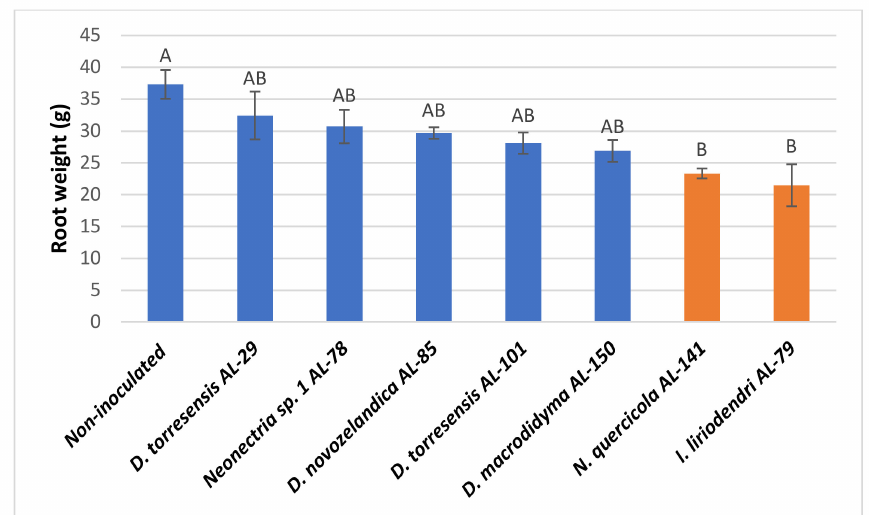
Figure 6. Weight of the root system of ‘Lauranne’ potted almond trees grafted onto ‘GxN-15’ rootstock inoculated with isolates of Cylindrocarpon -like anamorphs. Results are mean of ten trees per isolate and error bars correspond to the standard error. Data were subjected to analysis of variance (ANOVA) and different letters indicate significant differences according to LSD test at p <